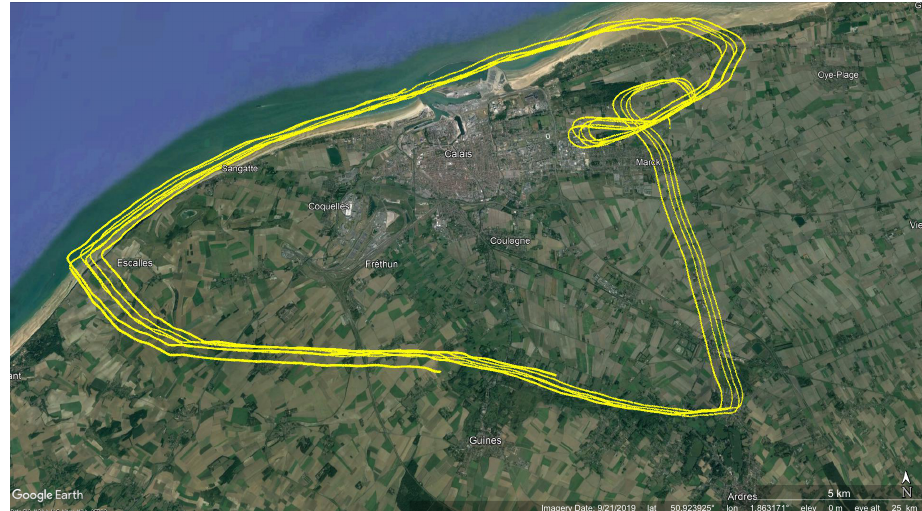
Figure 12. The satellite footprint traces along the flight trajectory imposed on Google Earth software. The traces of very low elevation satellites are not shown in the